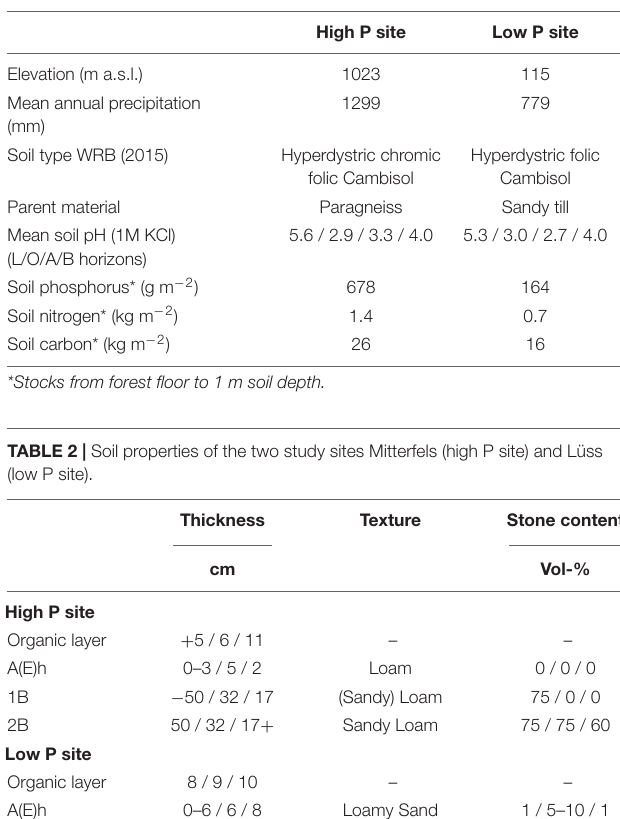
TABLE 1 | Site characteristics of the study sites Mitterfels (high P site) and Lüss (low P site), according to Lang et al. (2017).